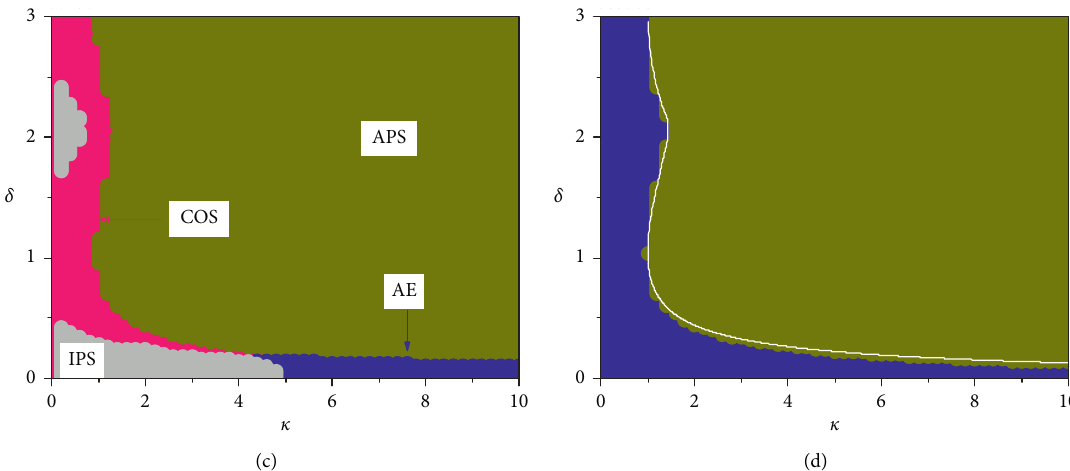
Figure 4: (a)–(d) Phase diagrams on the ( κ , δ ) plane for different dynamic parameter regions with p � 0 . 4, 0.6, 0.8, and 1.0, respectively. The parameter spaces are separated into four regions which correspond to aging effect (AE), in-phase synchronization (IPS), antiphase synchronization (APS), and the chimera oscillatory state (COS), respectively. The solid lines come from theoretical analysis.